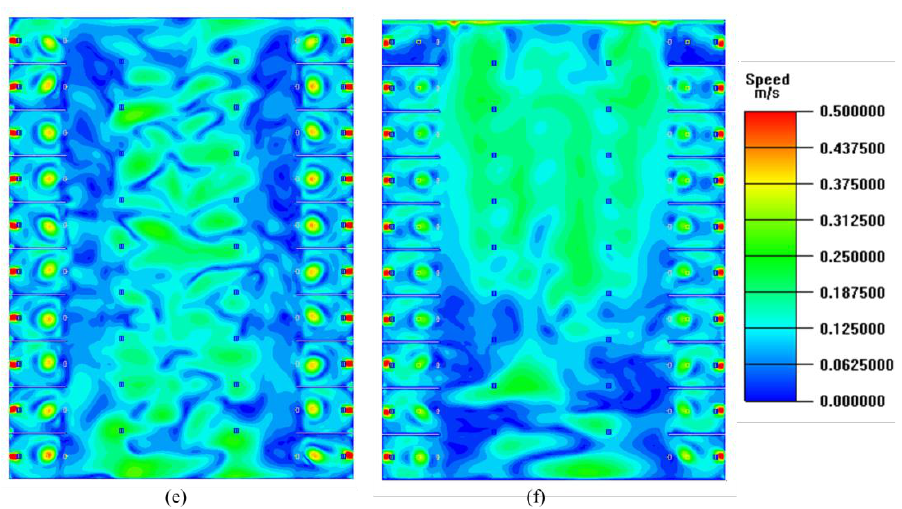
Figure 8. Velocity distribution at Y = 1.5 m: Scheme 1 in summer ( a ), Scheme 1 in winter ( b ), Scheme 2 in summer ( c ), Scheme 2 in winter ( d ), Scheme 3 in summer ( e ), and Scheme 3 in winter ( f ).